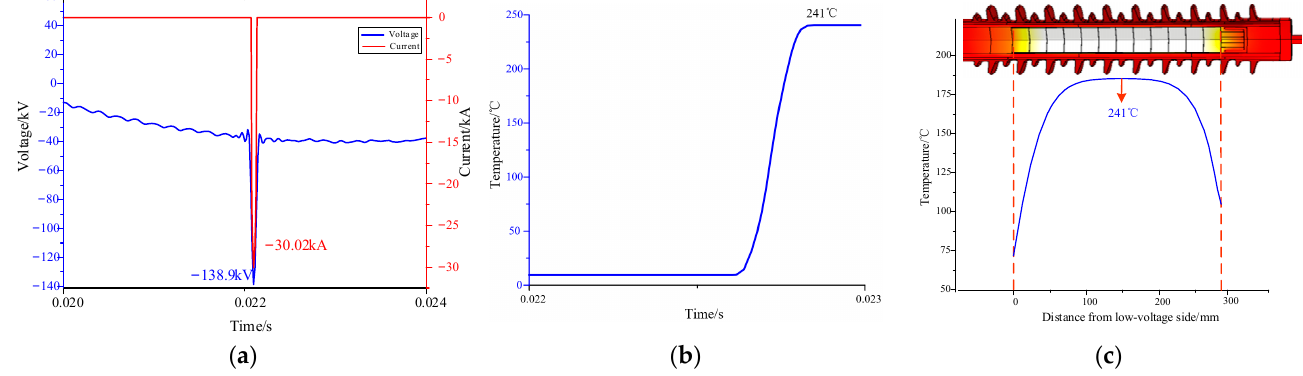
Figure 18. The current and temperature distribution of the arrester. ( a ) Steep impulse overvoltage and current. ( b ) Temperature variation of the arrester. ( c ) Temperature distribution of the valve column.